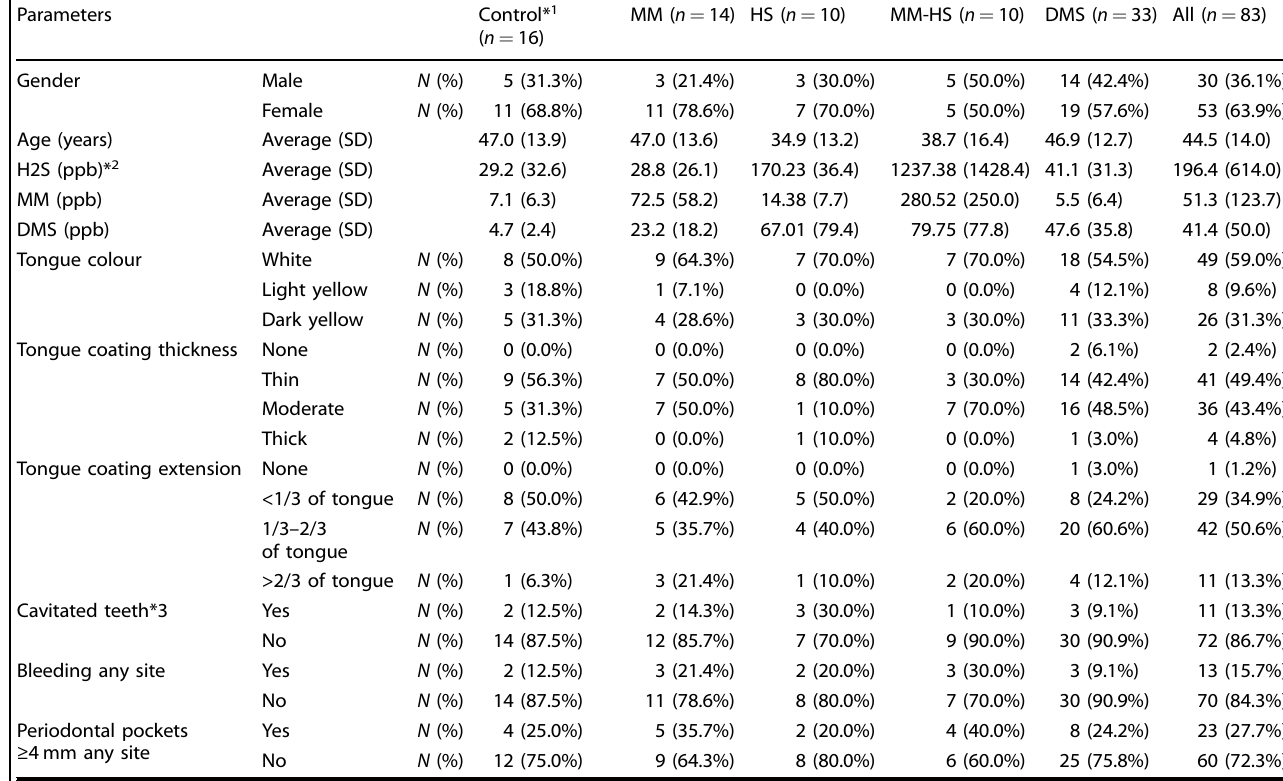
Table 1. summary of clinical parameters in the healthy control group and halitosis groups.